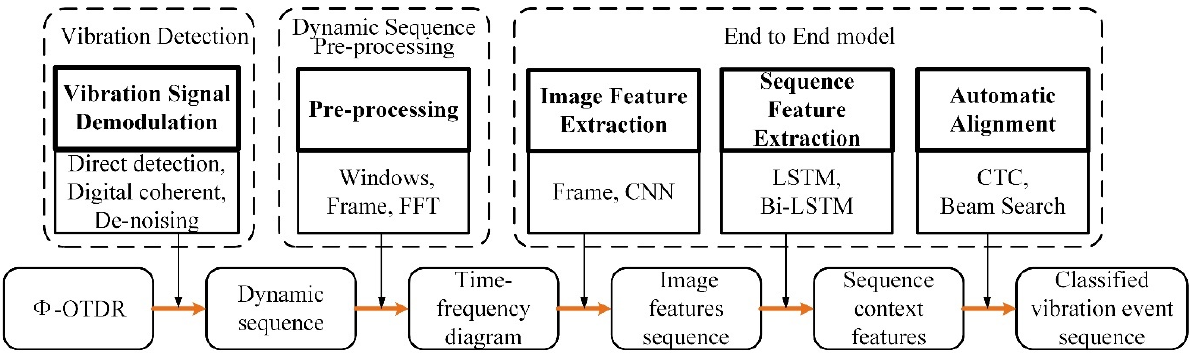
Figure 3. Workflow for end-to-end-based multi-vibration target detection.